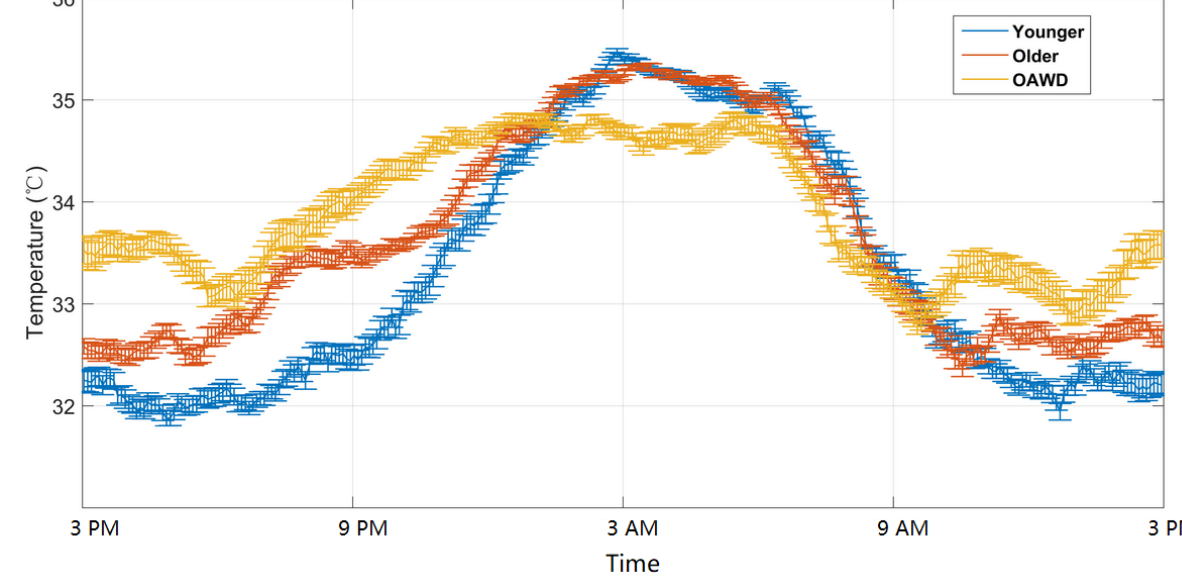
Figure 4. Average wrist temperature patterns for healthy younger adults, healthy older adults, and older adults living with dementia. Plots are expressed as the mean temperature (standard errors of the mean). OAWD: older adults living with dementia.